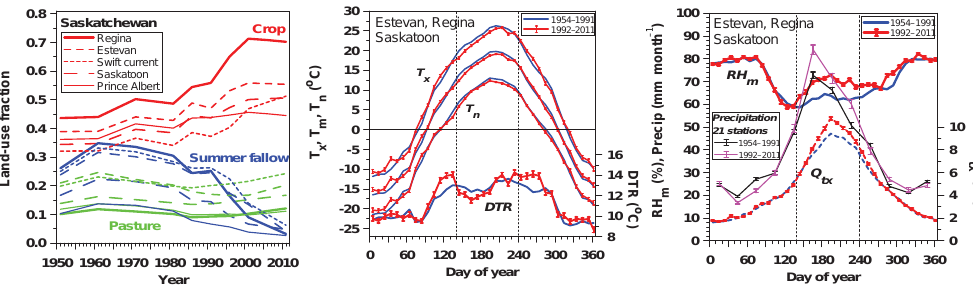
Figure 5. Long term trends in total cropland, pasture, and summer fallow around five climate stations in Saskatchewan (left panel); mean changes in annual cycle of DTR, T x , T m and T n for Saskatoon, Regina and Estevan (center panel) and RH m , Q tx and mean precipitation for 21 stations in southern Saskatchewan (right